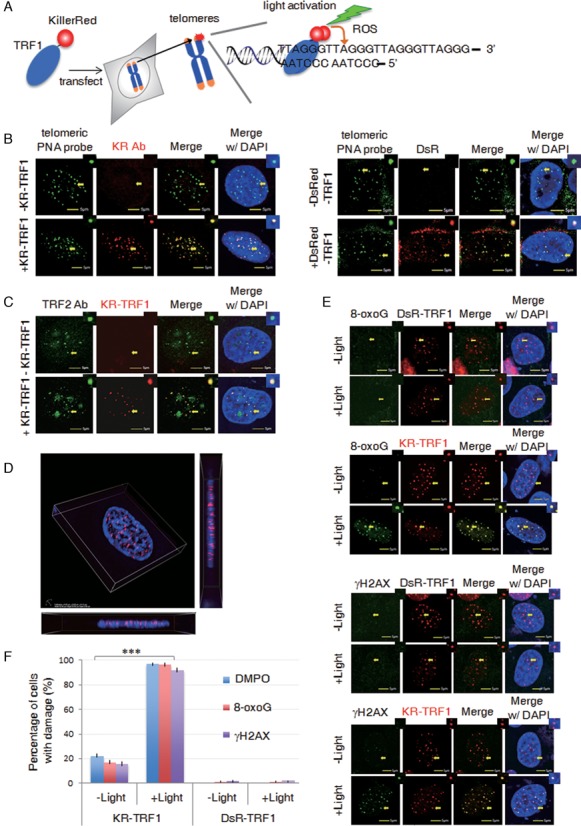
DNA Damage Targeted at Telomeres (DTT) using KillerRed-TRF1. (A) Schematic of the DTT system: visible light activation of KR-TRF1 induces localized oxidative DNA damage at telomere repeat sequences in living cells. (B) Colocalization of KR-TRF1 and PNA FISH-labeled telomeres in U2OS cells with or without transfection of KR-TRF1 (left panel) or DsRed tagged TRF1 (DsR-TRF1) detected by KR or DsRed antibody (right panel). (C) Immuno-staining of endogenous TRF2 with or without KR-TRF1 expression in U2OS cells. (D) Representative three-dimensional super-resolution image of KR-TRF1 using 3D-SIM. The lateral resolution is ∼100 nm and the axial resolution is ∼240 nm. (E) Production of telomeric site-specific DNA damage by KR-TRF1 after light illumination. Immuno-staining of DsR-TRF1 or KR-TRF1 transfected U2OS cells with anti-8-oxoG and anti-γH2AX. Scale bar equals 5 μm. (F) Quantification of colocalizations from (e). Mean values with SDs from 150 cells in three independent experiments are given. P-value is calculated by Student's t-test, ** P < 0.005. Arrows indicate the enlarged area shown at the right top of each image.